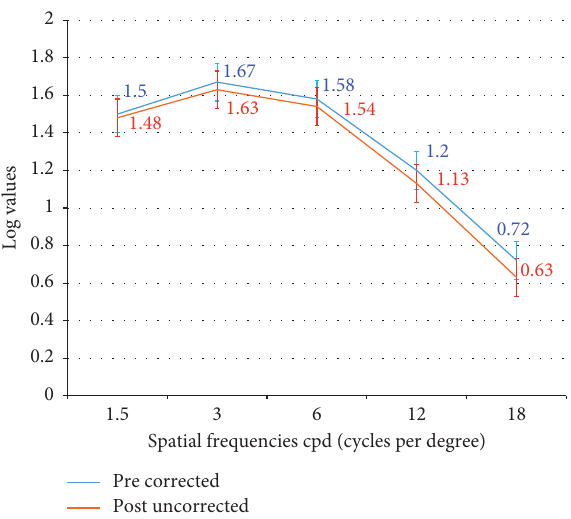
Figure 6: Contrast sensitivity (F.A.C.T) at 6 months post-op.